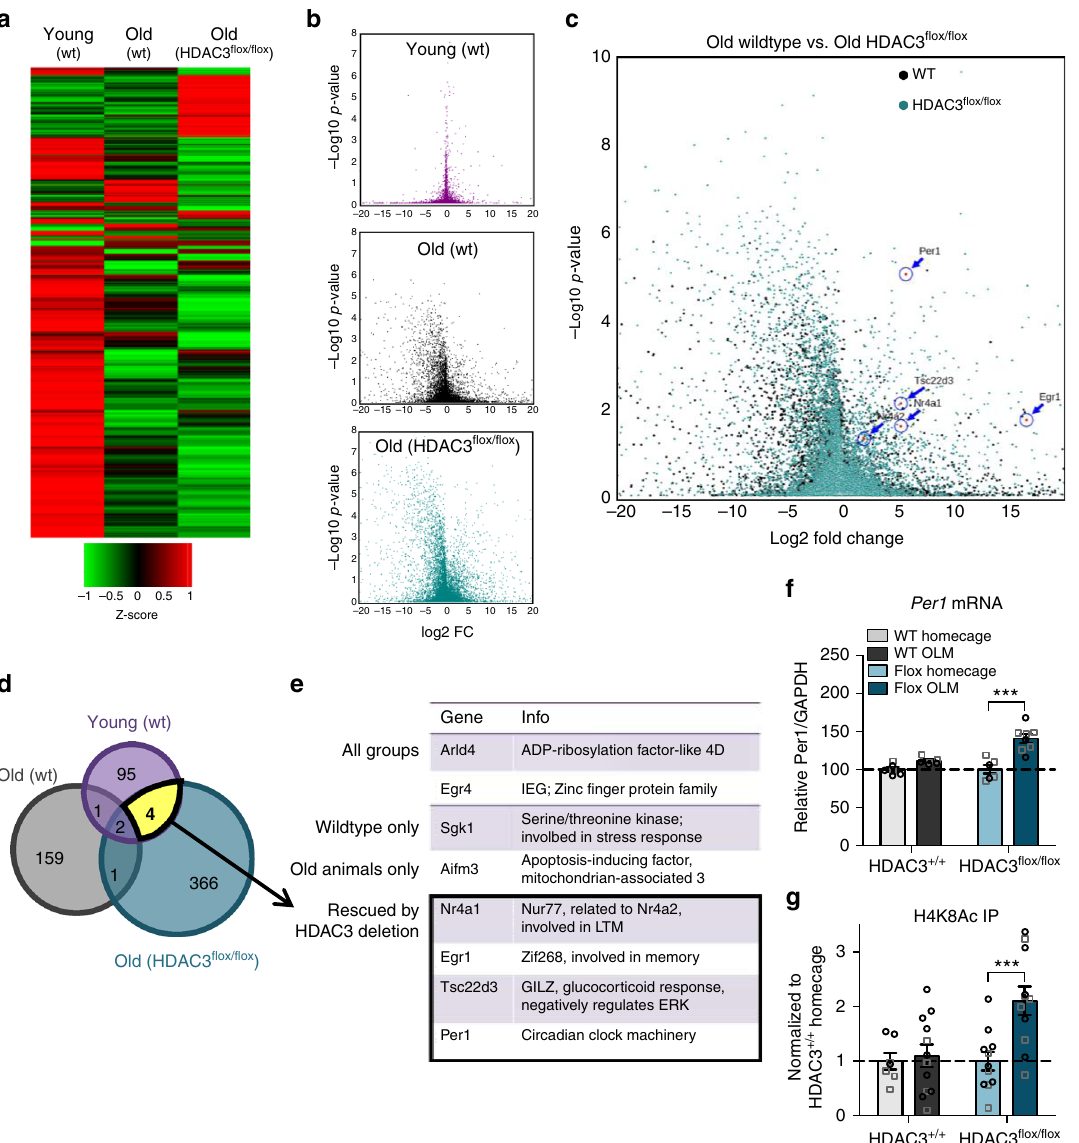
Fig. 3 A subset of experience-induced genes is impaired with age and rescued by HDAC3 deletion. a Heat map comparing experience-induced gene changes in each group (Young wt: HC n = 6(3F), OLM n = 6(3F); Old wt: HC n = 6(2F), OLM n = 6(2F); Old HDAC3 fl ox/ fl ox : HC n = 8(5F), OLM n = 8 (5F)). Each row represents an individual gene. Color legend shown at bottom; red, upregulation; green, downregulation. b Volcano plots illustrating the signi fi cance ( Y -axis) and magnitude ( X -axis) of experience-induced changes in each group. Young animals showed fewer experience-induced changes in gene expression compared to old wildtype or old HDAC3 fl ox/ fl ox mice. c Overlapping volcano plot comparing old wildtype and old HDAC3 fl ox/ fl ox groups. Per1 was strongly induced by OLM training in HDAC3 fl ox/ fl ox mice. d Gene expression diagram displaying genes expressed higher in trained animals compared to homecage controls. Total gene count shown inside circles. e Table listing experience-induced genes common to two or more groups. Of particular interest are the four genes “ rescued by HDAC3 deletion ” that are upregulated in the young wildtype and old HDAC3 fl ox/ fl ox groups but are not upregulated in the old wildtype group. f Per1 mRNA expression is increased in the 18-m.o. brain in the absence of HDAC3 (Two-way ANOVA: Genotype x Train ( F (1,22) = 9.48, p < 0.01), Sidak ’ s post hoc tests, ** *p < 0.001; n = 6(2F), 6(3F), 6(4F), 8(5F)). g Occupancy of H4K8Ac at the Per1 promoter is upregulated by OLM training in the 18-m.o. hippocampus in the absence of HDAC3 (Two-way ANOVA: Genotype x Train ( F (1,37) = 5.5, p < 0.05), Sidak ’ s post hoc tests, *** p < 0.001, n = 7(4F), 12(4F), 11(4F), 11(6F)). Data are presented as mean ± SEM; black circles, males; gray squares,